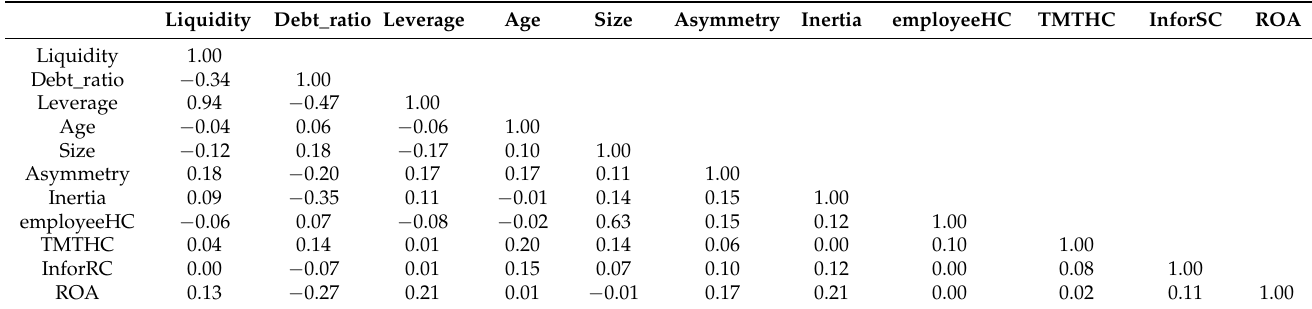
Table 3. Correlation analysis